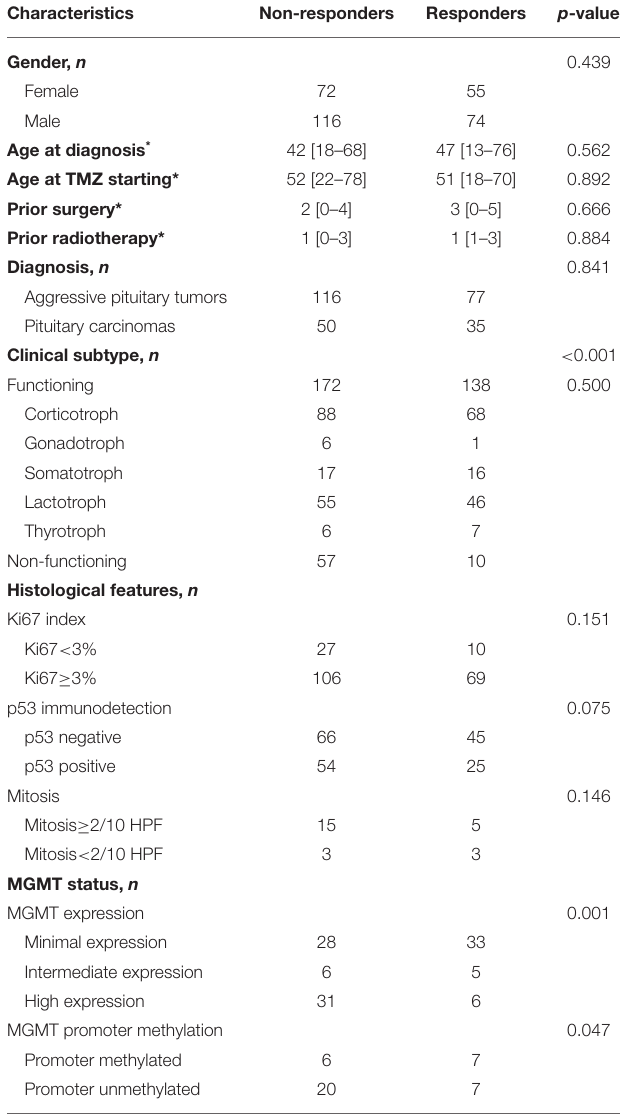
TABLE 2 | Key features of APT and PC patients in TMZ responders and non-responders.